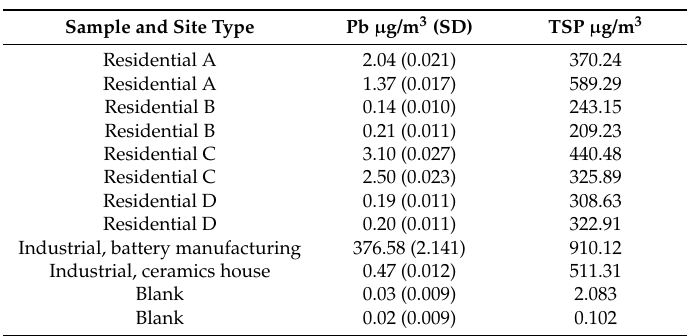
Table 2. Concentrations for lead (Pb) and total suspended particles (TSP) measured by energy dispersive X-ray fluorescence (EDXRF) spectrometry in 8-h samples (7 L/min flow rate) collected in Munshiganj, Bangladesh, in January 2018. Samples taken within the same sampling site grid cell are indicated by site identifier A–D.